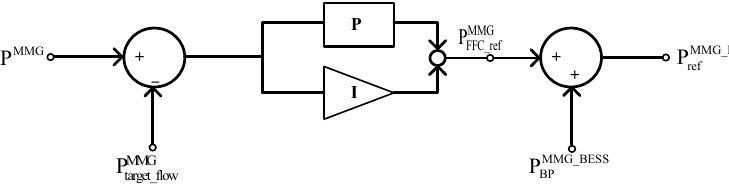
Figure 5. Control block of the BESS to manage flow of the MMG PCC. P MMG : measured value of the power flow from the utility to the MMG; P MMG : target flow of the MMG; P MMG : output reference needed to maintain the flow of the MMG; P MMG _ BESS : base point of the MMG BESS necessary to restore the SOC of the BESS; P MMG _ BESS : output reference of the MMG